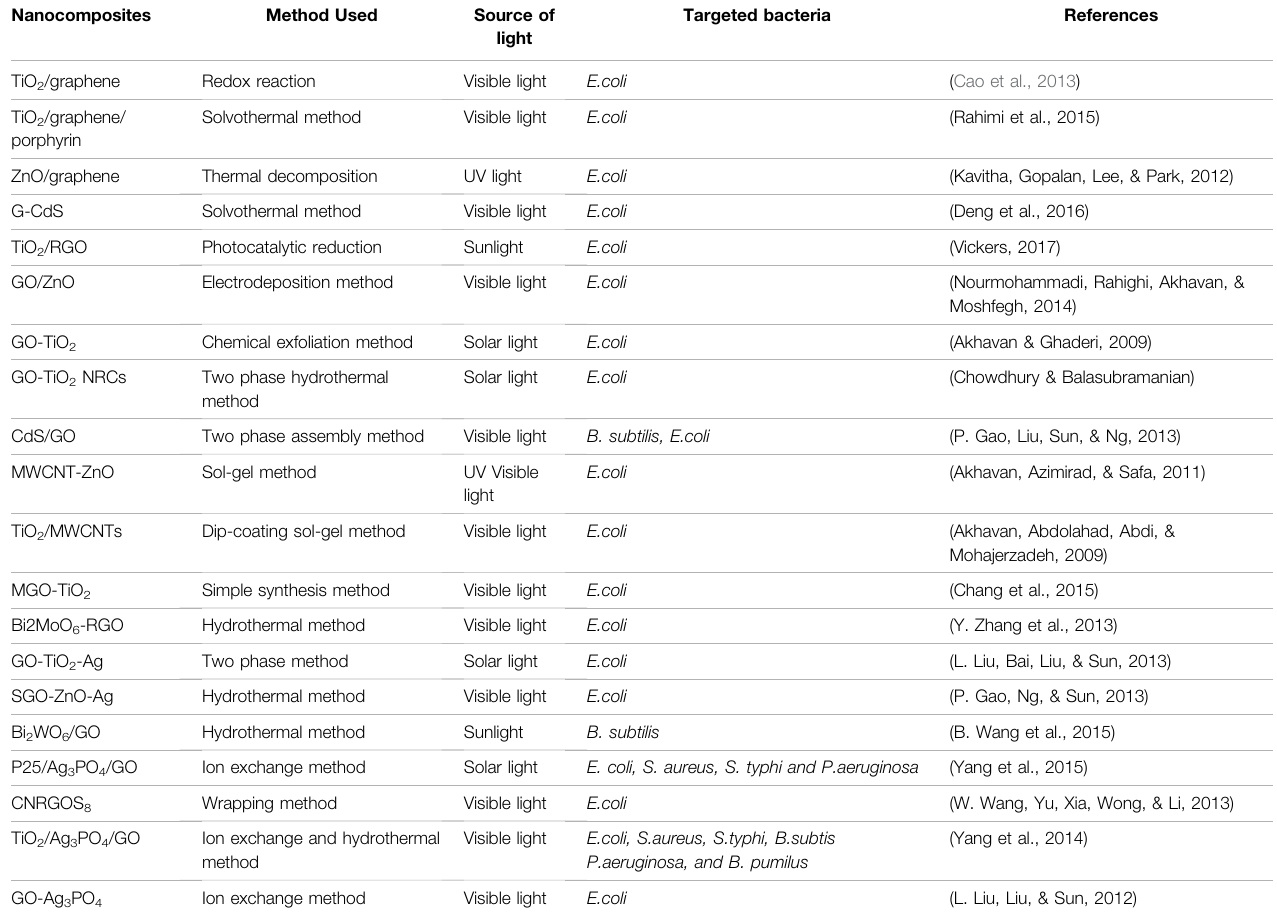
TABLE 5 | Graphene mediated bacterial disinfection in water (adapted from Singh et al. (2020)).